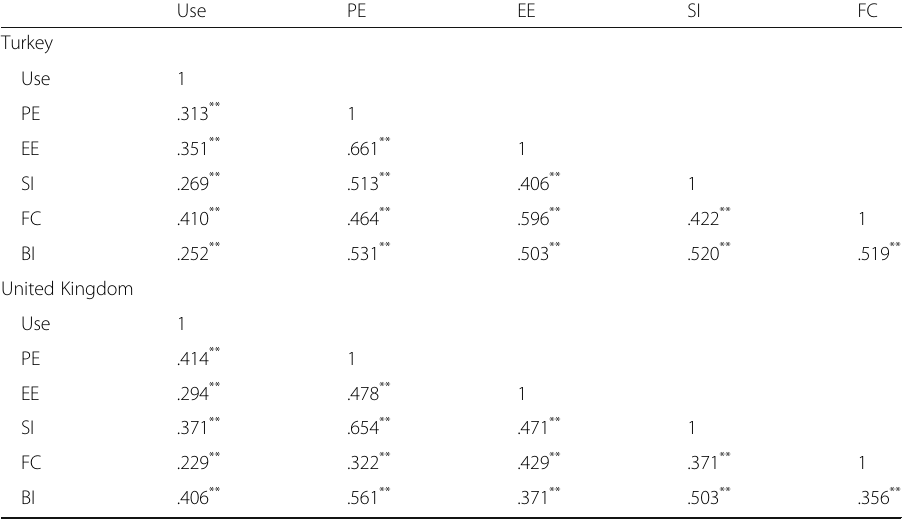
Table 3 Intercorrelations between the variables Use